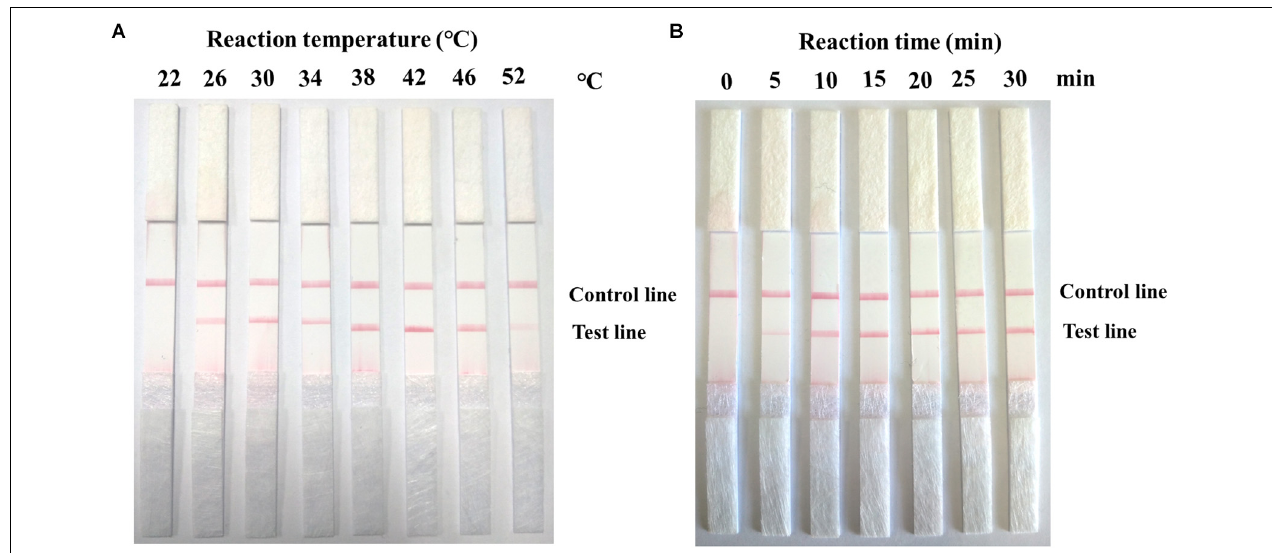
FIGURE 3 | Optimal detection conditions of ASFV RPA-LFD assay. (A) The assay works from 26 ◦ C to 46 ◦ C. (B) After 5 min of amplification, the test line is visible on the lateral flow